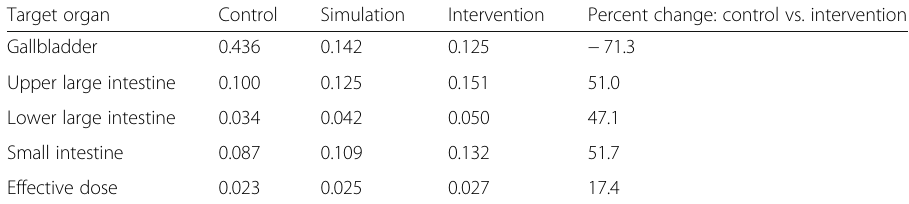
Table 3 Comparing control, simulation, and intervention groups (mSv/MBq) Target organ Control